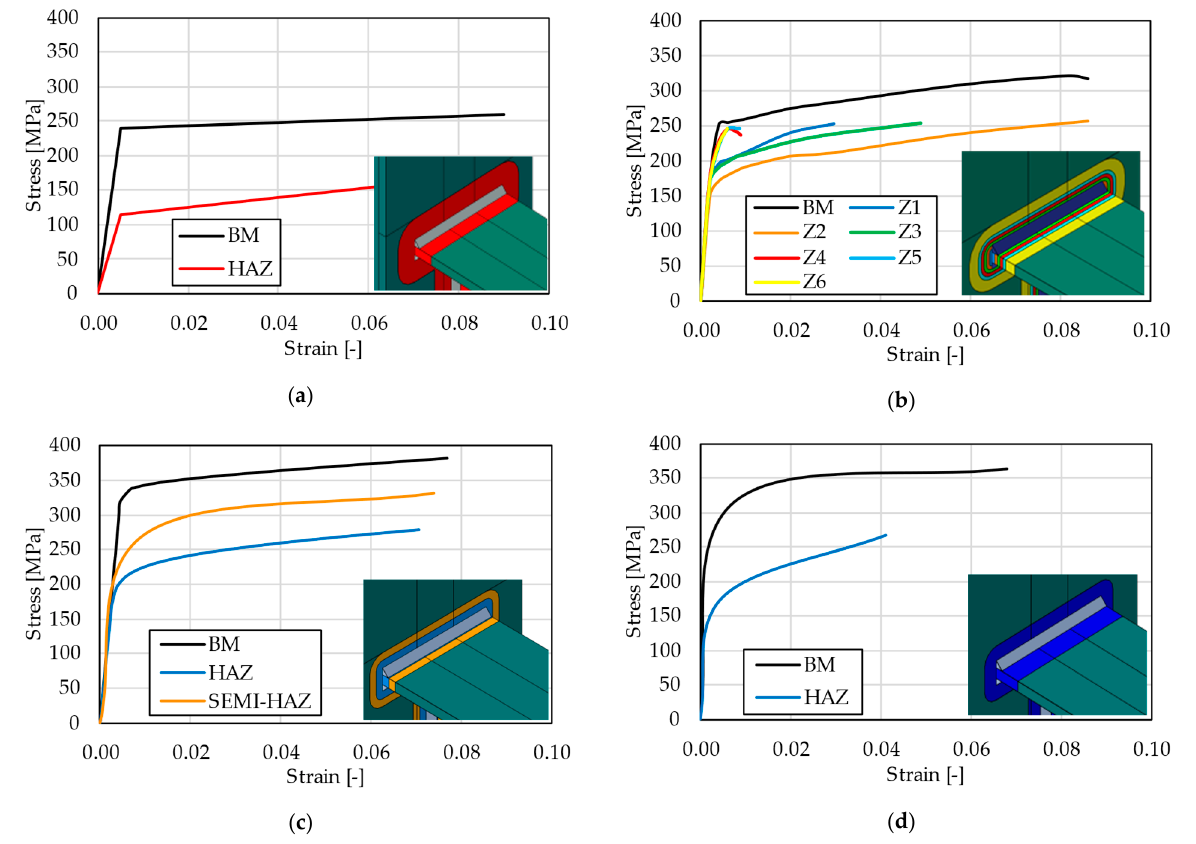
Figure 5. Stress–strain behaviour for numerical models: ( a ) AL_EC6061-T6_R30; ( b ) AL_N6061-T6_xx; ( c ) AL_S6082-T6_xx; ( d ) AL_T6082-T6_xx.